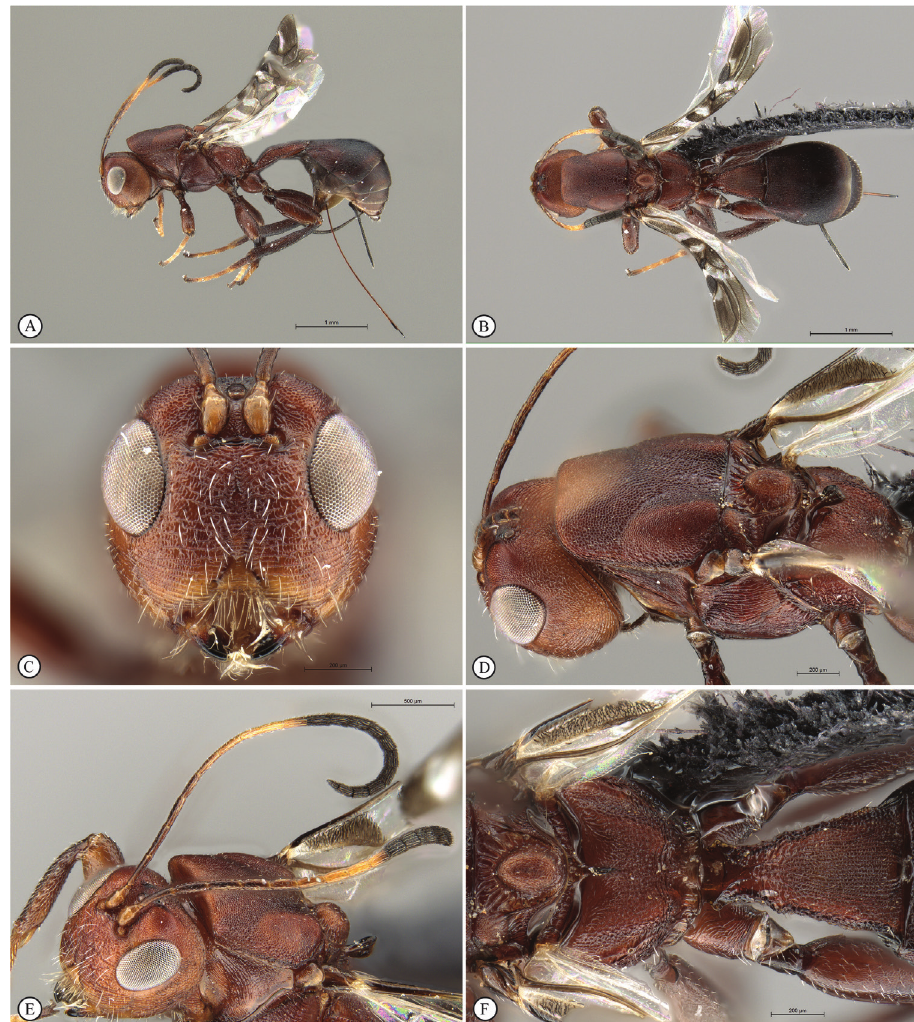
Figure 1. Spathioplites phreneticus , female South Africa SAM-HYM-P086343 (SAMC) A habitus, lateral view B habitus, dorsal view C head, anterior view D head, mesosoma, dorso-lateral view E antennae, head, mesosoma, antero-dorsal view F scutellum, propodeum, first tergite, dorsal